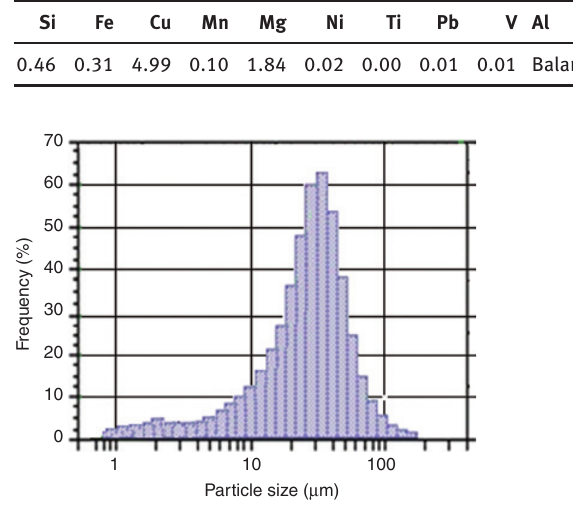
Figure 1 Particle size distribution of reinforced SiC.